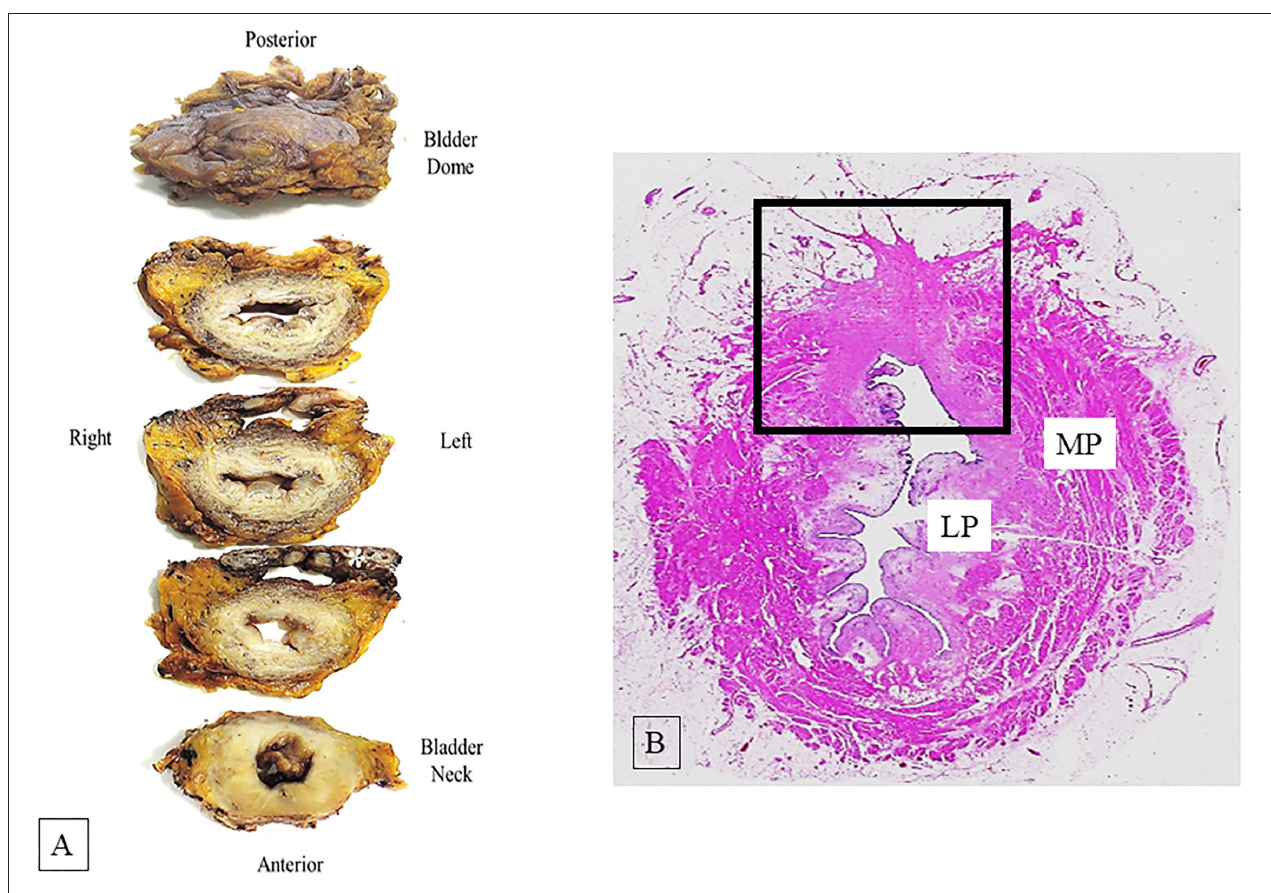
FIGURE 1 | (A) Serial dissected bladder transversely from the bladder neck to the dome at 5mm intervals. The asterisk indicates the seminal vesicles. (B) Hematoxylin-eosin whole mount section shows bladder wall architecture; muscularis propria (MP) and lamina propria (LP). The square area indicates a site of a previous transurethral resection (TUR) showing fibrosis of the bladder